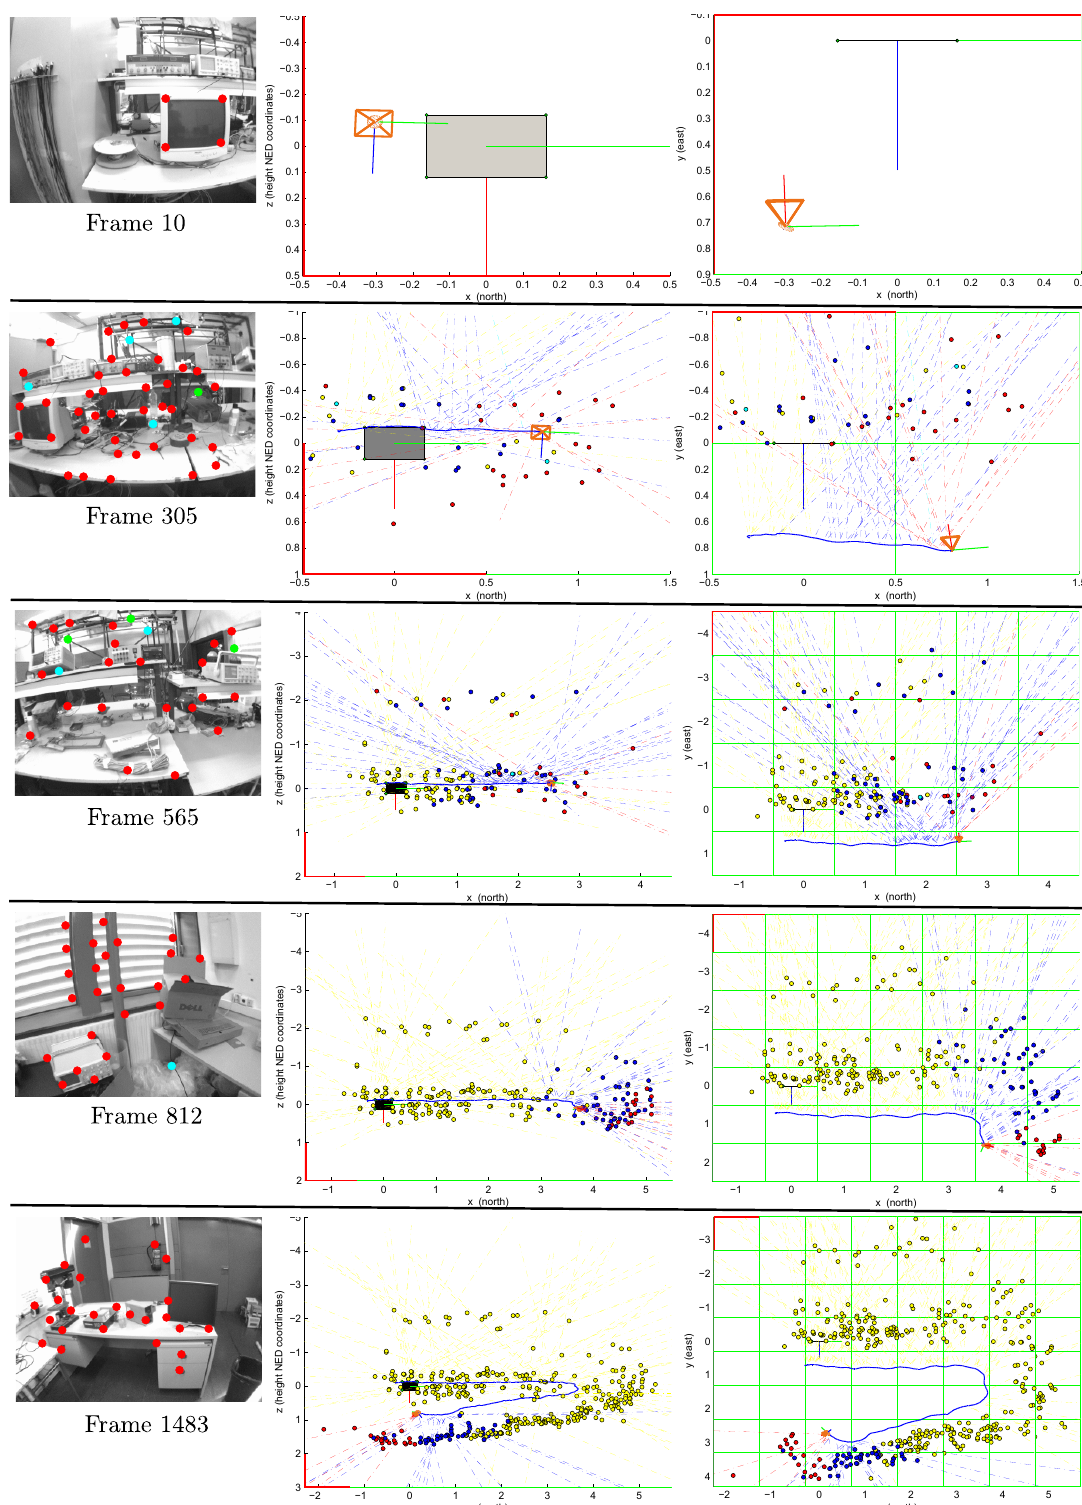
Figure 6. Input images (left column), camera trajectory and map estimations (z–x view; central column) (x–y view; right column) for a video sequence containing about 1,750 frames reordered in a laboratory environment. Frames 10, 305, 565, 812 and 1,483 are